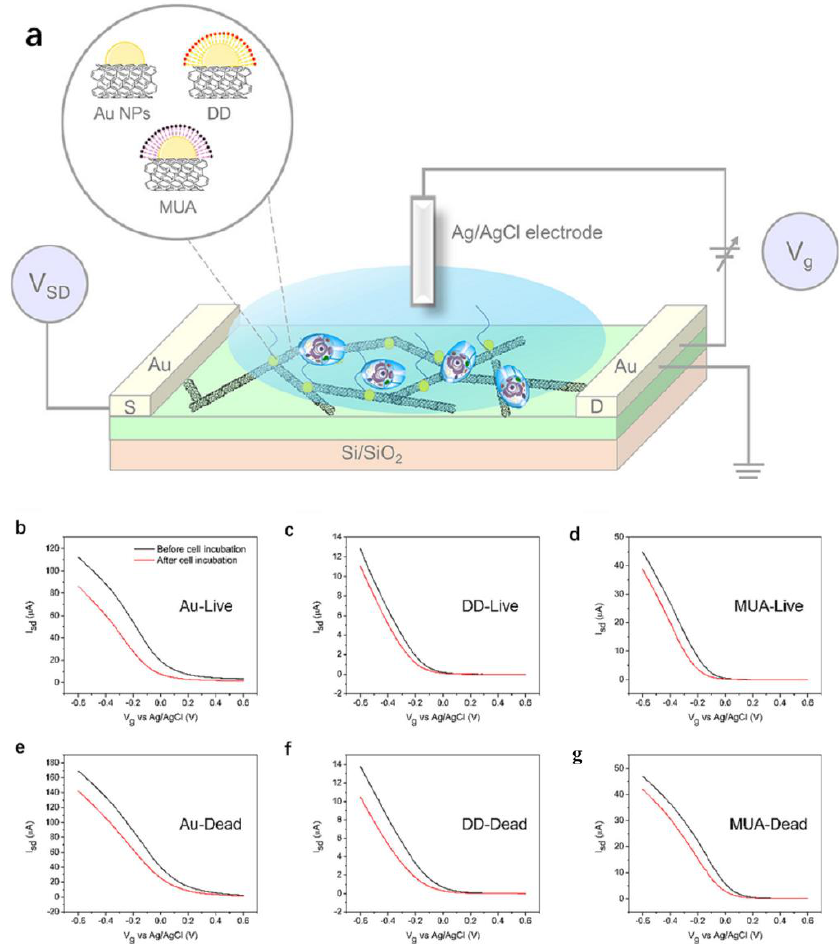
Figure 9. ( a ) The transmission characteristics of the CNT-FET, i.e., the relationship between the source- drain current (Isd) and the applied liquid gate voltage, have different decorative and liquid-gated NTFET schematics after the cell culture; ( b ) The transfer characteristics of NTFET were modified with bare gold nanoparticles; ( c ) dodecyl mercaptan; ( d ) 11-mercaptoundecanoic acid after the incubation in the living cells; ( e ) Transfer characteristics of NTFET after the incubation with bare gold nanoparticles; ( f ) 1-dodecanethiol; ( g ) 11-mercaptoundecanoic acid in dead cells. Reproduced from Liu et al. [157] by permission of the American Chemical